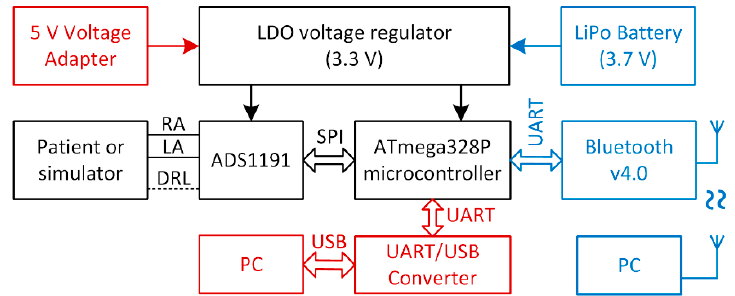
Figure 3. Block diagram of the measurement system. A red scenario stands for powering the ECG system by an AC / DC adapter where data are transferred to the PC via a USB cable. A blue scenario stands for a battery-powered ECG system where data are transferred wirelessly via Bluetooth.